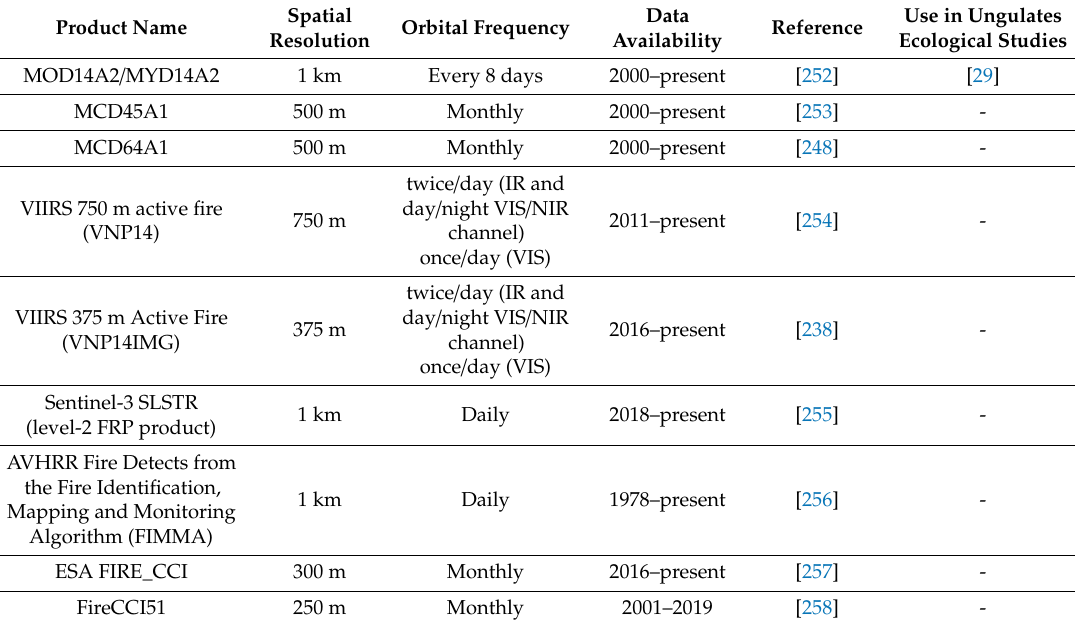
Table 6. Non-exhaustive list of satellite remote sensing-based fire